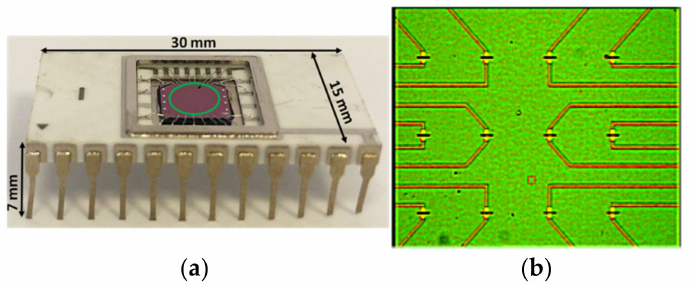
Figure 1. Photographic images of ( a ) a mounted silicon nanoribbon (Si-NR) chip (top view; green circle indicates the sensitive area of the chip), and ( b ) sensitive area of the chip, containing an array of twelve NRs ( b